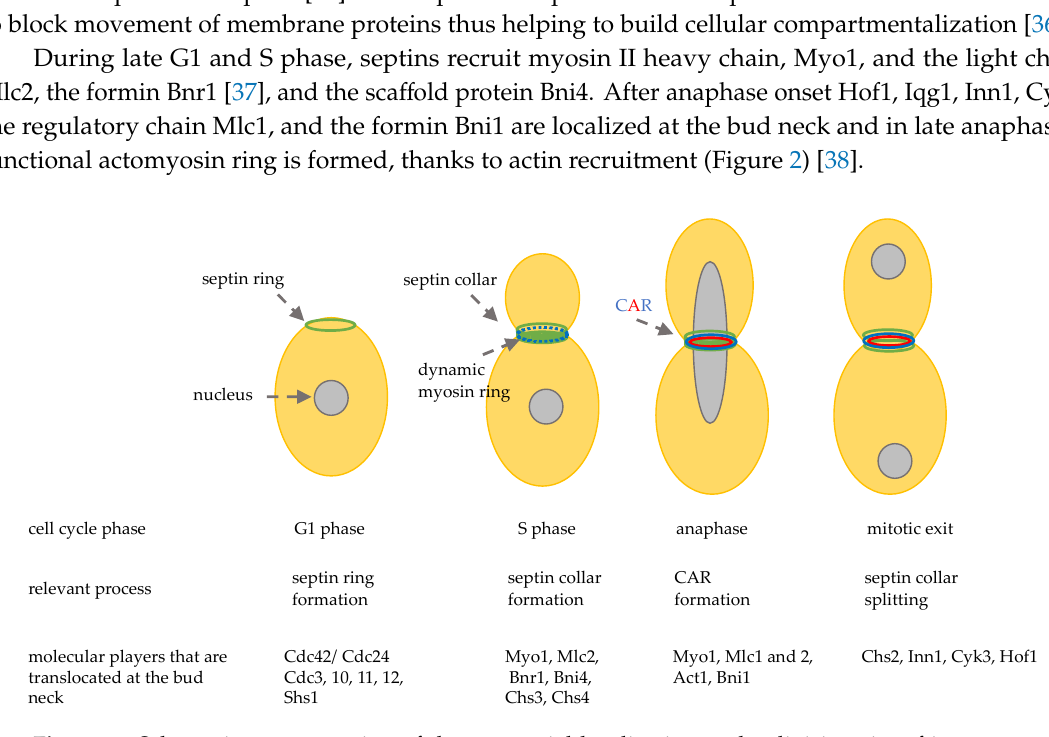
Figure 2. Schematic representation of the sequential localization at the division site of important cytokinesis players. CAR: contractile actomyosin ring.